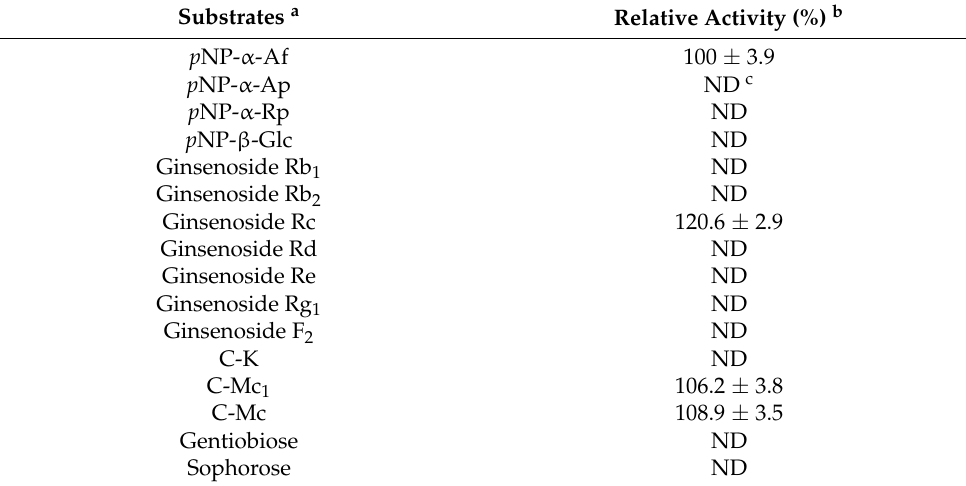
Table 4. Substrate specificity of BsAbfA.